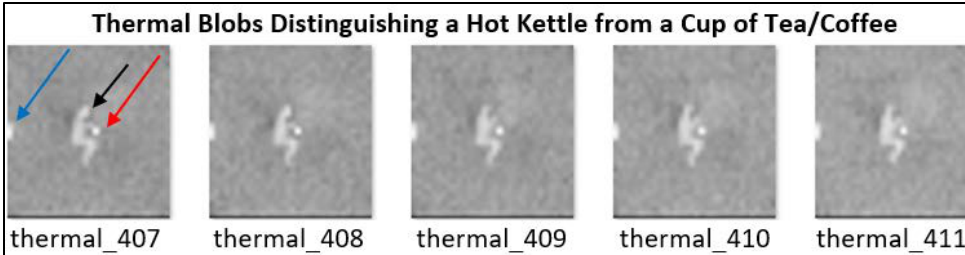
Figure 5. Distinguishable thermal blobs. On thermal_407, the blue arrow points to the hot kettle, the black arrow points to the participant, and the red arrow to the tea/coffee cup after the initial act of tea/coffee making. In some instances, the heat spot of a cup or kettle may be occluded by a participant when it is viewed from the lateral thermal sensor (see, Figure 6 ). When this happens, abnormal behaviours or activities may go unnoticed. To